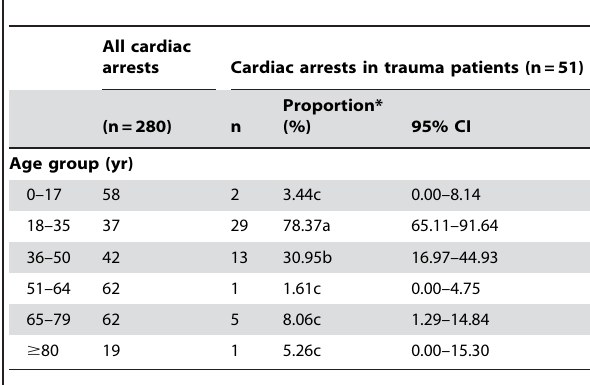
Table 1. Intraoperative cardiac arrest proportions in trauma patients by the number of all cardiac arrests in all patients, grouped by